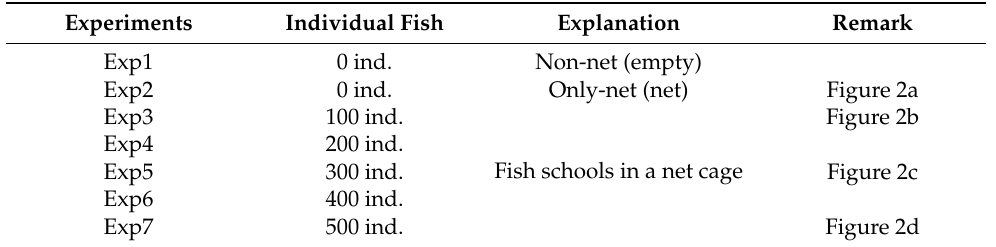
Table 1. Attenuation experiments with varying number of individual fish (Japanese horse